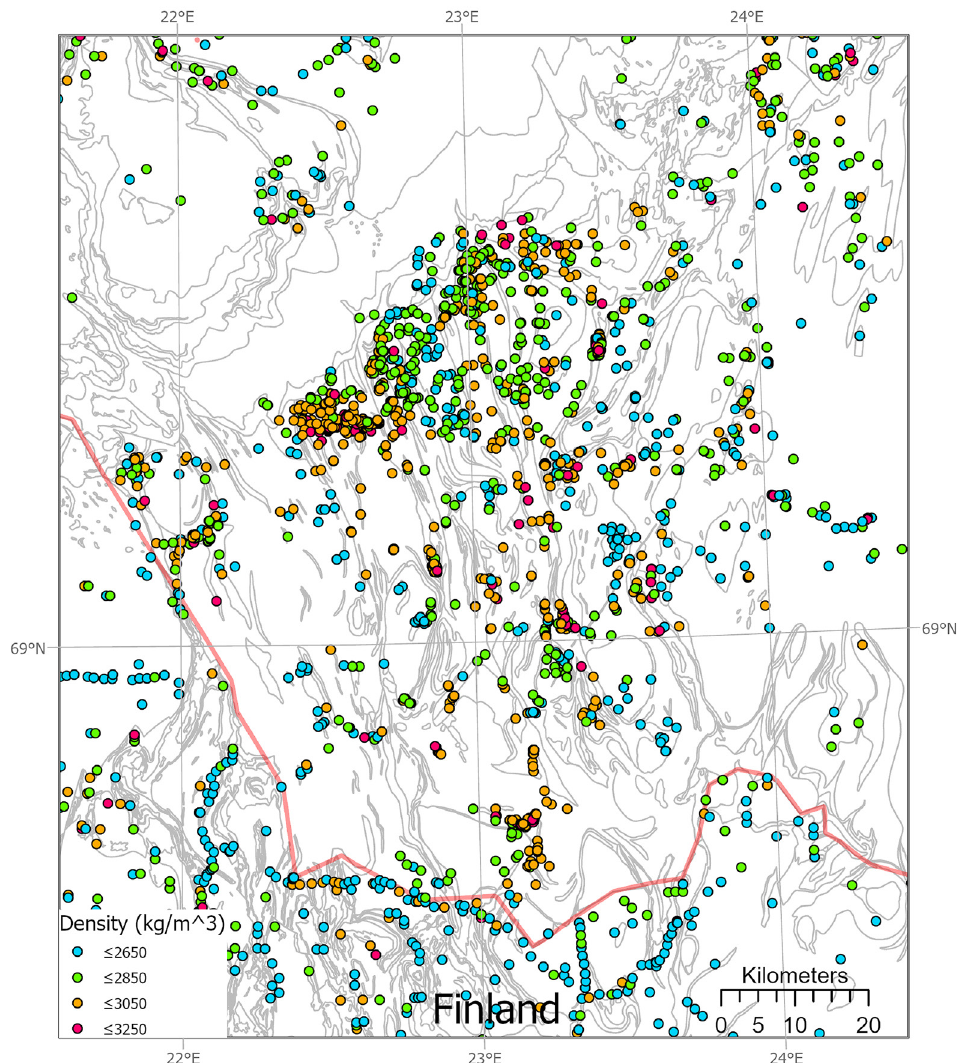
Figure 5. Density measurements (kg/m3) within the study area. Data from NGU and